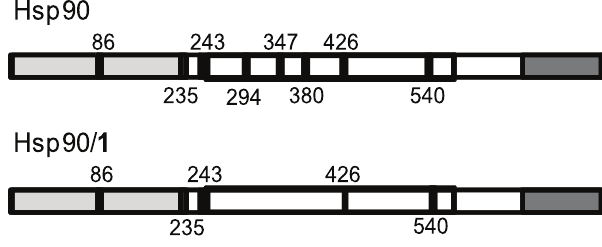
Figure 5. Schematic representation of the results obtained from limited proteolysis experiments. The preferential cleavage sites detected on recombinant Hsp90, and on the Hsp90/ 1 complex are in black. The Hsp90 N-terminal domain is highlighted in light grey, the middle domain is boxed and the C-terminal domain is highlighted in